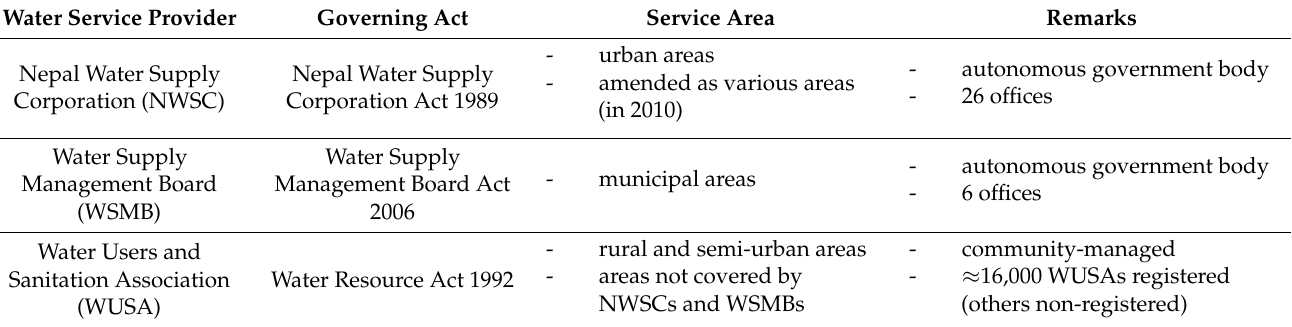
Table 1. Water service providers in Nepal.